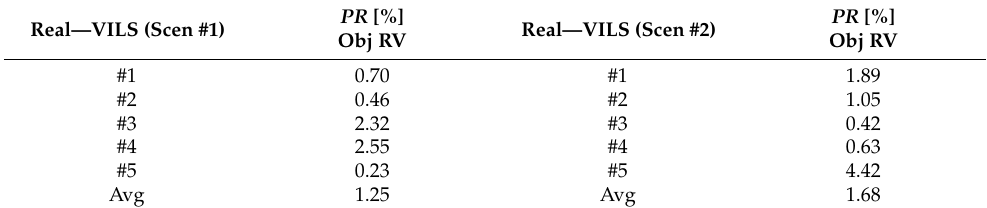
Table 3. Data Comparison Result—Object relative velocity